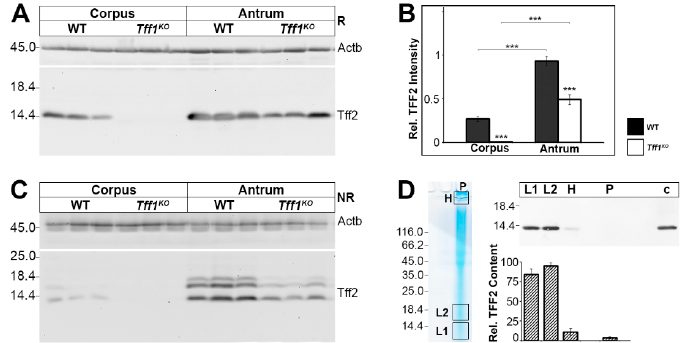
Figure 3. Western blot analyses of gastric corpus and antrum extracts of female wild-type (WT) and female Tff1 KO animals. Extracts of two animals per group were separated by 1% agarose gel electrophoresis. Shown are the reactivities for Tff1 and Fcgbp, respectively. As a positive control for Fcgbp, two murine colon extracts were analyzed (C1, C2). The start and the dye bromophenol blue (BPB) are marked on the left.